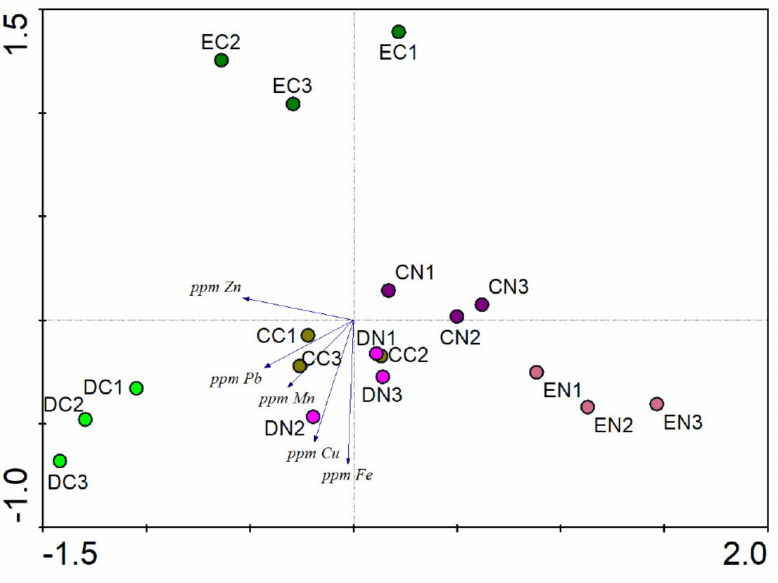
Figure 5. PCA ordination diagram showing the spatial arrangement of samples (points) with regard to the foliar concentrations in trace elements (arrows), plant species, and soil (contaminated or uncontaminated). CC= contaminated soil under C. salviifolius , CN= uncontaminated soil under C. salviifolius , DC= contaminated soil under D. viscosa , DN= uncontaminated soil under D. viscosa , EC= contaminated soil under E. pithyusa , EN= uncontaminated soil under E. pithyusa . The PCA performed with the concentrations of trace elements in roots for the three plant species (Figure 6) did not show a clear separation between C. salviifolius in contami- nated and uncontaminated soils. In general, samples of E. pithyusa and D. viscosa under contaminated and uncontaminated soil were separated although to a lesser extent than for the foliar trace elements. In contaminated soils, D. viscosa was the highest root accumulator of Fe, Pb, Mn, and Zn, while E. pithyusa accumulated the most Cu. These two species growing in uncontaminated soil registered low metal accumulation in the roots while E. pithyusa had the lowest root concentration of